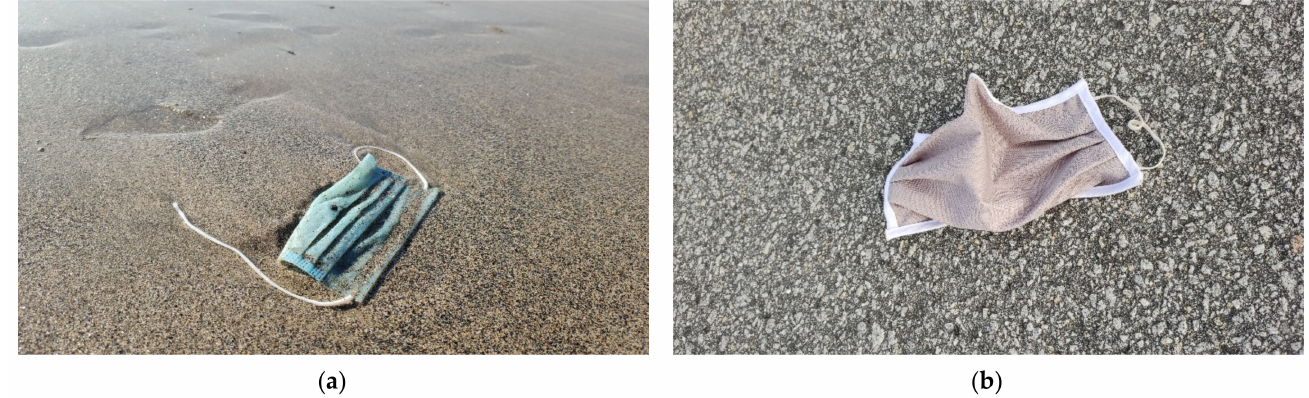
Figure 1. Incorrect disposal of masks observed in Portugal: ( a ) disposable masks on a beach and ( b ) reusable mask on an urban